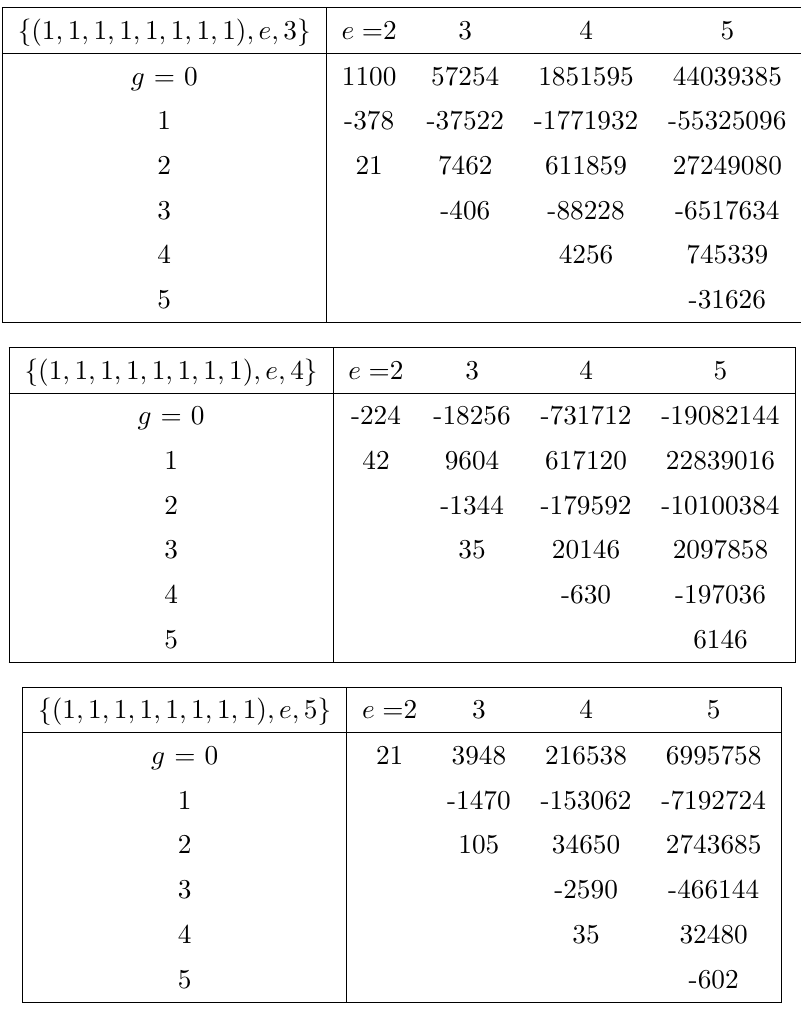
Table 13 . Unrefined GV invariants from (2,0) E 8 SCFT at base degree (1,1,1,1,1,1,1,1), fiber degree 2 to 5 and mass degree 3, 4 and